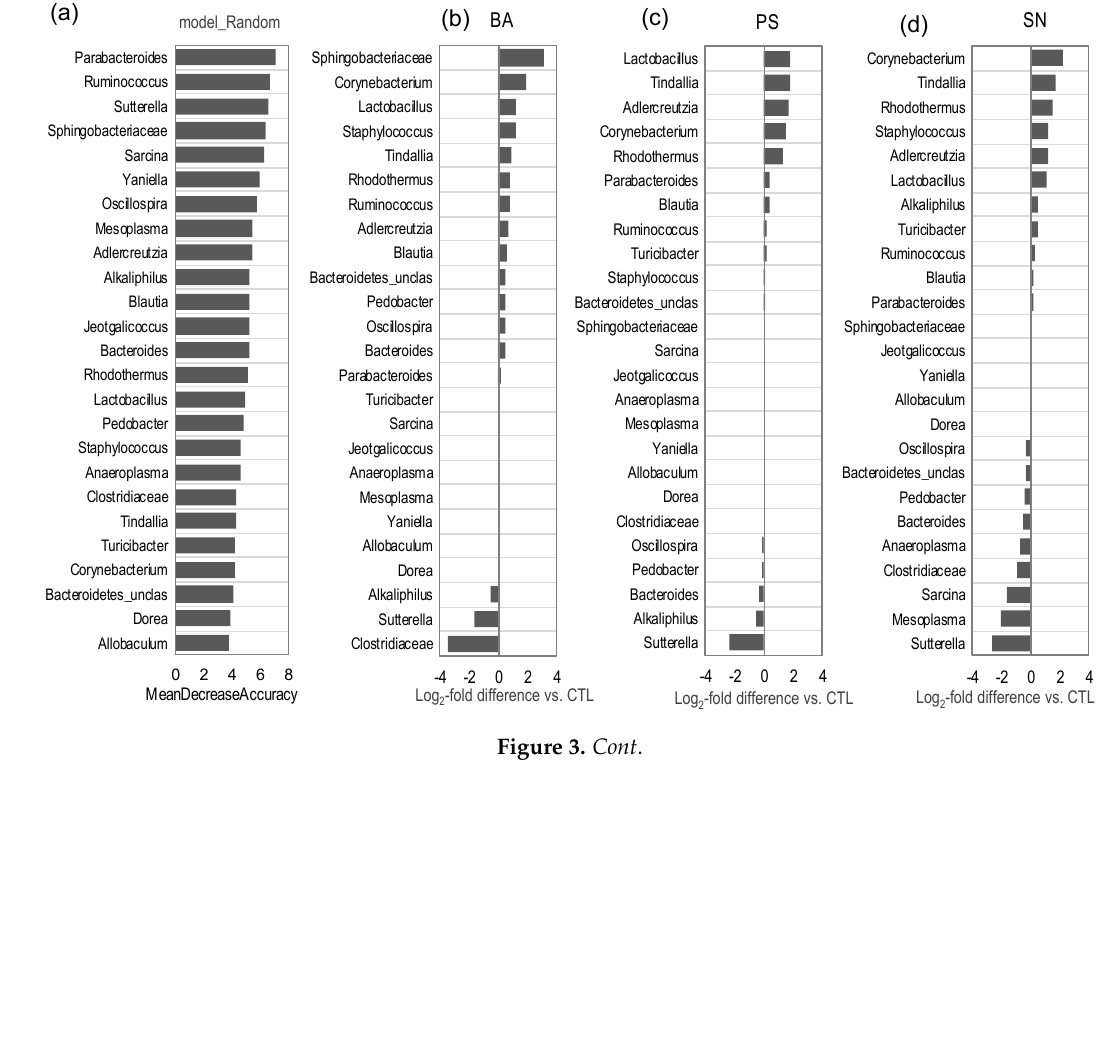
Figure 3. Specific microbiota signatures in mice consuming different preservatives. ( a − d ) The random forest graph shows the most predictive bacterial phyla, orders, families, and genera influenced by the intake of specific preservatives. ( e , f ) Linear discriminatory analysis (LDA) effect size (LEfSe) cladogram ( e ) and LDA bar plot ( f ) representing the bacterial taxa significantly unique in mice consuming benzoate (BA), potassium sorbate (PS), or sodium nitrite (SN) versus control (CTL) mice. 4. Discussion Food preservatives are commonly added to increase the shelf-life of food products. Benzoic acid, potassium sorbate, and sodium nitrate are among the food industry’s top food preservatives. The benzoic acid is added to control the growth of yeast and mold [8]. Their antimicrobial efficacy is associated with microbial membrane disruption, inhibition of metabolic reactions, and accumulation of toxic anions in the microbial cells [28]. Sorbic acid is incorporated in foods to inhibit the growth of yeast, molds, and Gram-negative (e.g., Campylobacter , Clostridium , Escherichia coli O157:H7, Salmonella ) and Gram- positive foodborne pathogens (e.g., Staphylococcus ) [8]. Whereas sodium nitrate is highly